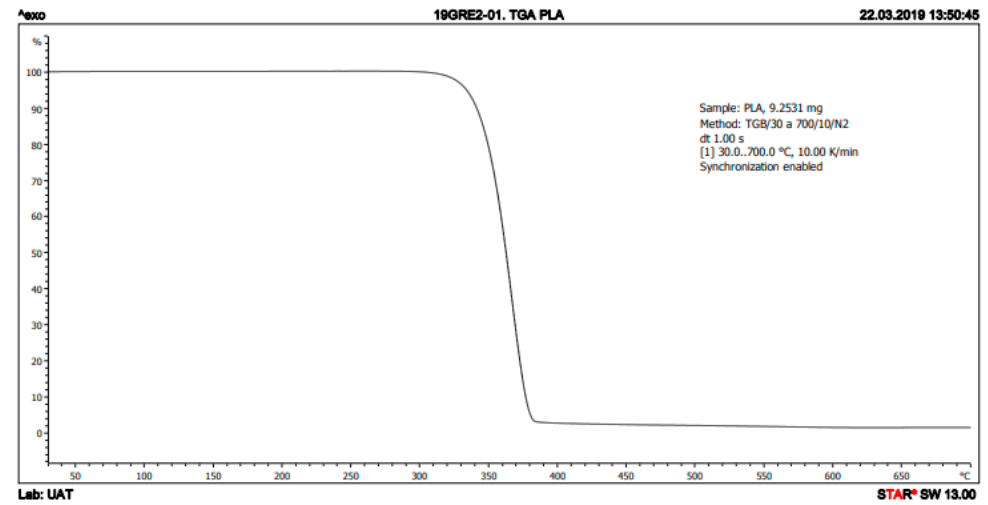
Figure 2. TGA curve of PLA.